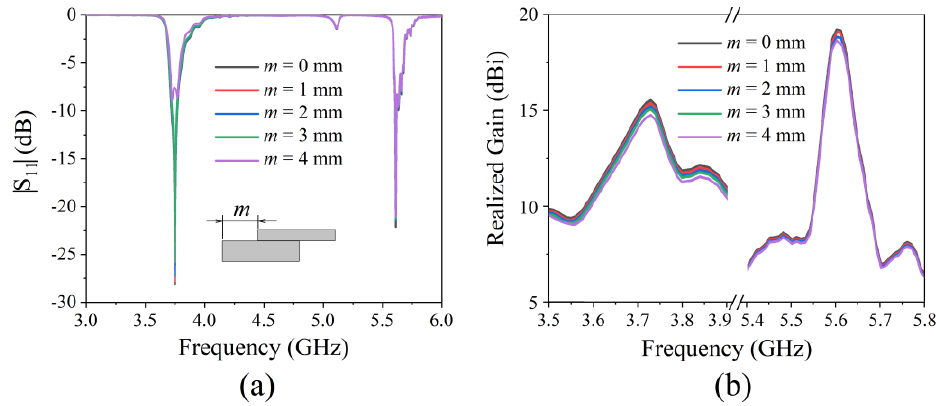
Figure 9. The effect of layer misalignment on radiation performance: ( a ) |S 11 |; ( b ) realized gain.